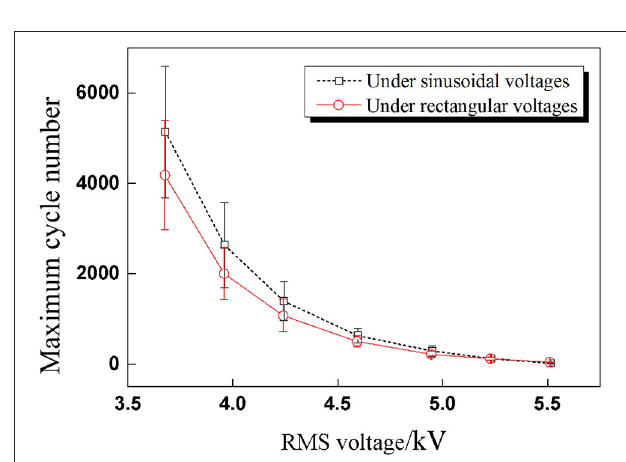
FIGURE 9 | Comparison results of maximum cycle number under sinusoidal and rectangular voltages with seven RMS voltages (the effective voltage values are the same for each